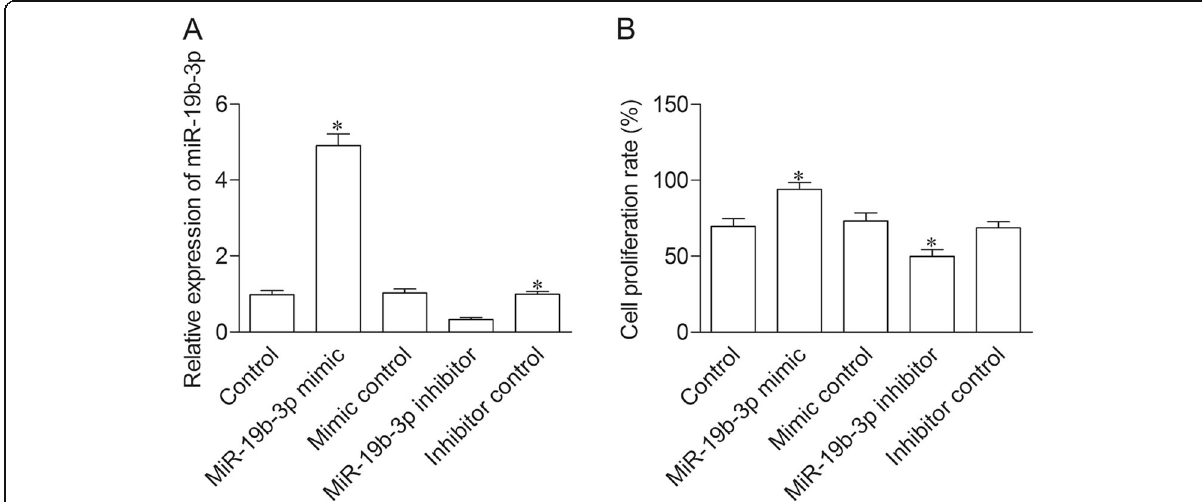
Fig. 2 MiR-19b-3p promotes proliferation of BMSCs. Control group, BMSC cells treated with BMP-2; miR-19b-3p mimic group, BMP-2 treated cells transfected with miR-19b-3p mimic; mimic control group, BMP-2 treated cells transfected with mimic control; miR-19b-3p inhibitor group, BMP-2 treated cells transfected with miR-19b-3p inhibitor; inhibitor control group, BMP-2 treated cells transfected with inhibitor control. ( a ) The expression of miR-19b-3p was measure by qRT-PCR. ( b ) Cell proliferation rate was evaluated by BrdU assay. * P < 0.05 versus healthy control